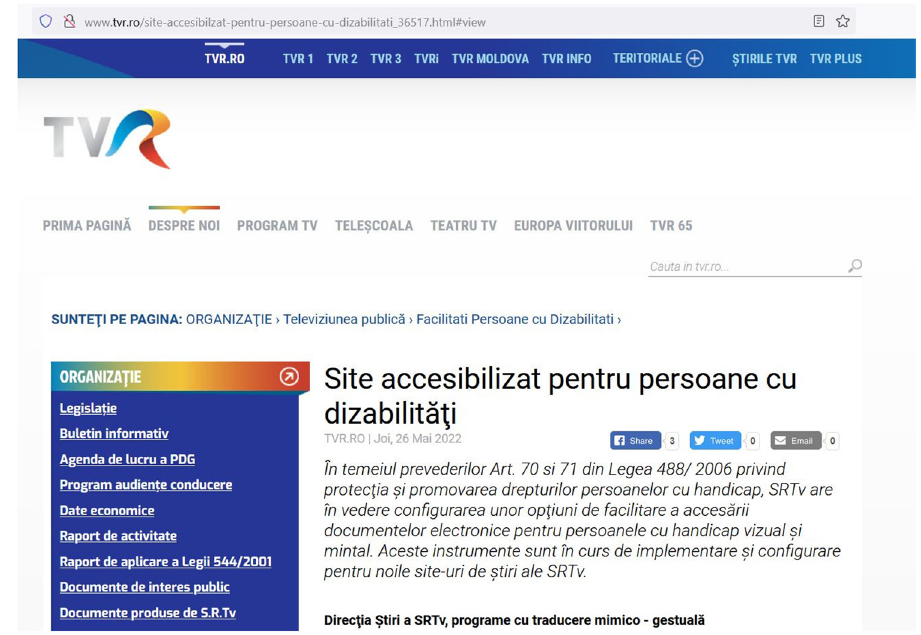
Figure 5: Televiziunea român ă [ Romanian Television Broadcasting Company ]